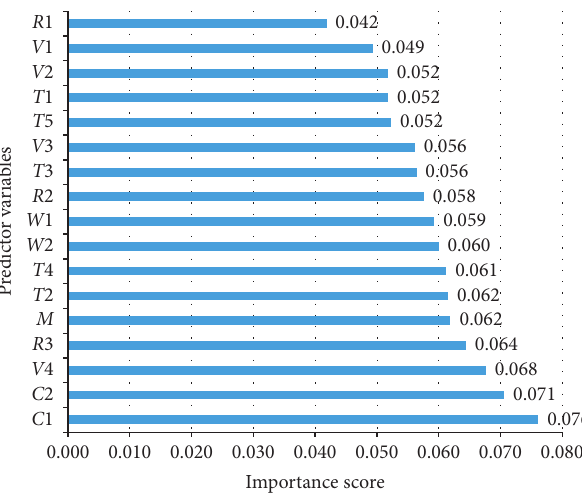
Figure 5: Relative importance of predictor